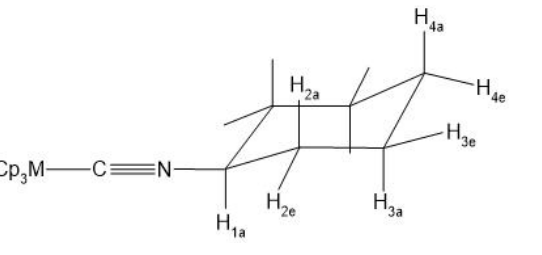
Figure 5. Schematic drawing of (Cp) 3 M(C ≡ Ncy) with the proton labeling used in the assignment of the NMR signals.